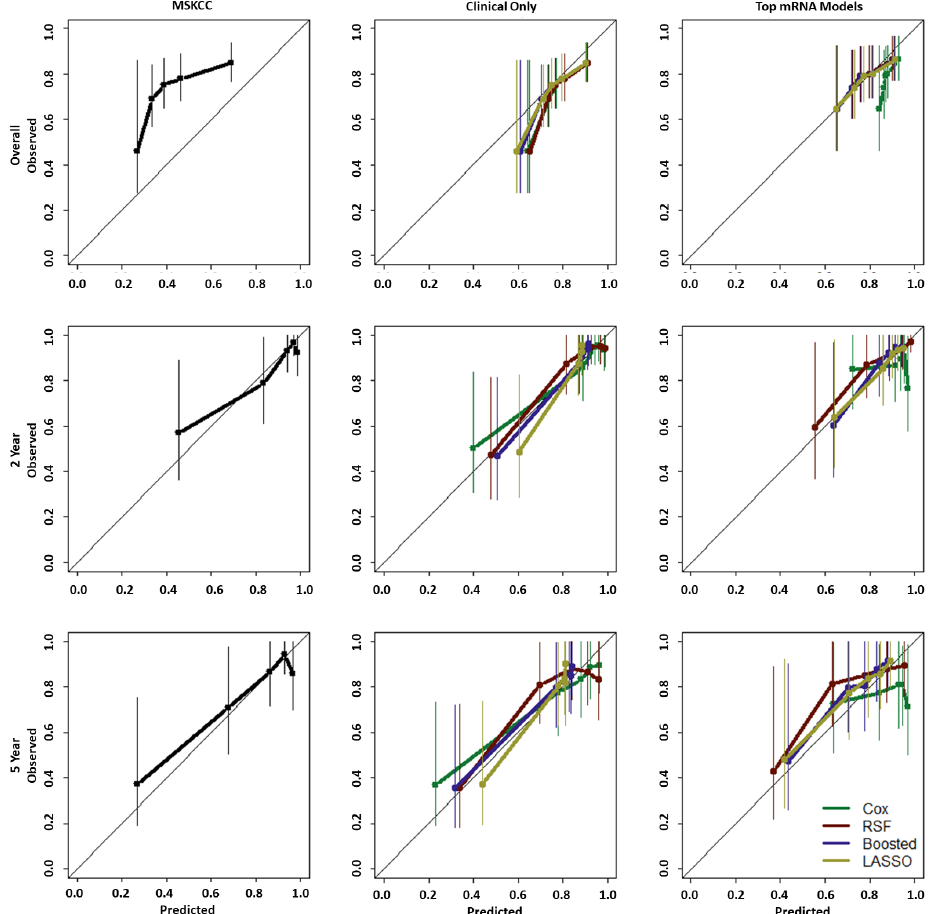
Figure 2. Calibration curves for MSKCC ( left ), clinical-only models ( centre ) and best-performing mRNA-based models ( right ) for (from top to bottom ) overall, 2-year and 5-year